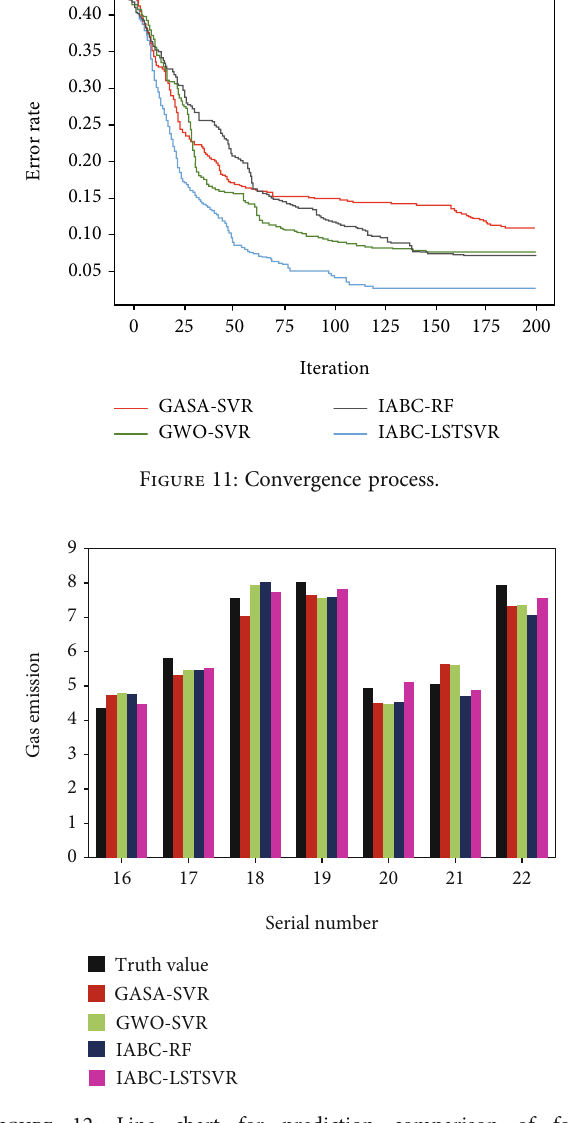
Figure 12: Line chart for prediction comparison of four algorithms.